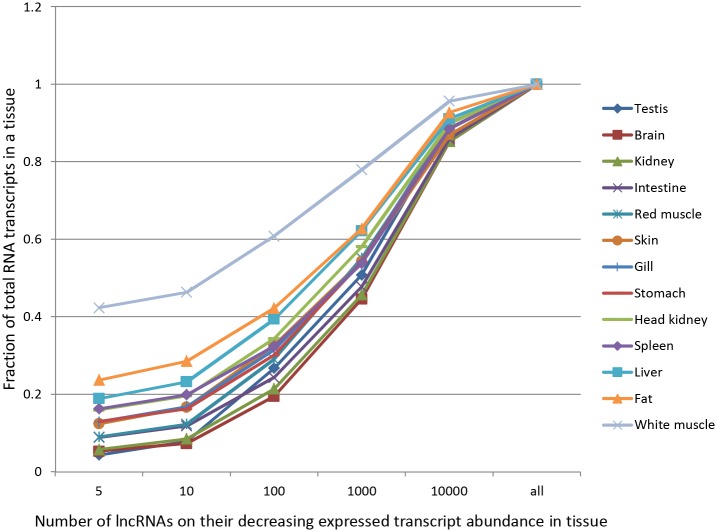
Distribution of lncRNA expression in various tissues.Proportion of the transcriptome that is contributed by the most abundant lncRNAs is plotted in various tissues. In complex tissues like brain and testis, larger number of lncRNAs were expressed with fairly equal dominance of many transcripts. On the contrary, less complex tissues like white muscle, fat and liver showed that majority of transcriptome is contributed by few dominant lncRNAs.